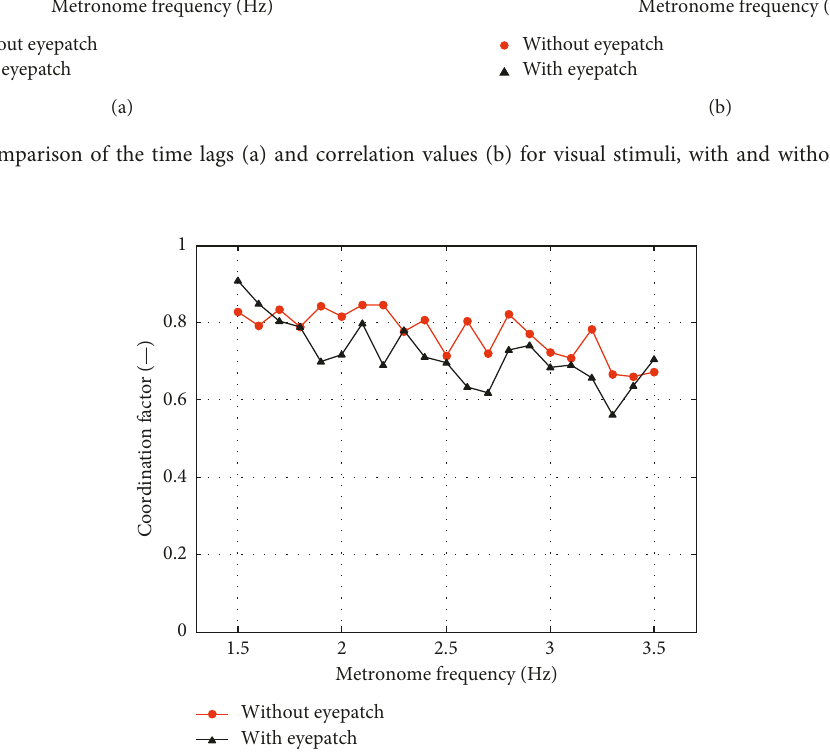
Figure 36: Comparison of the coordination factors for visual stimuli, with and without an